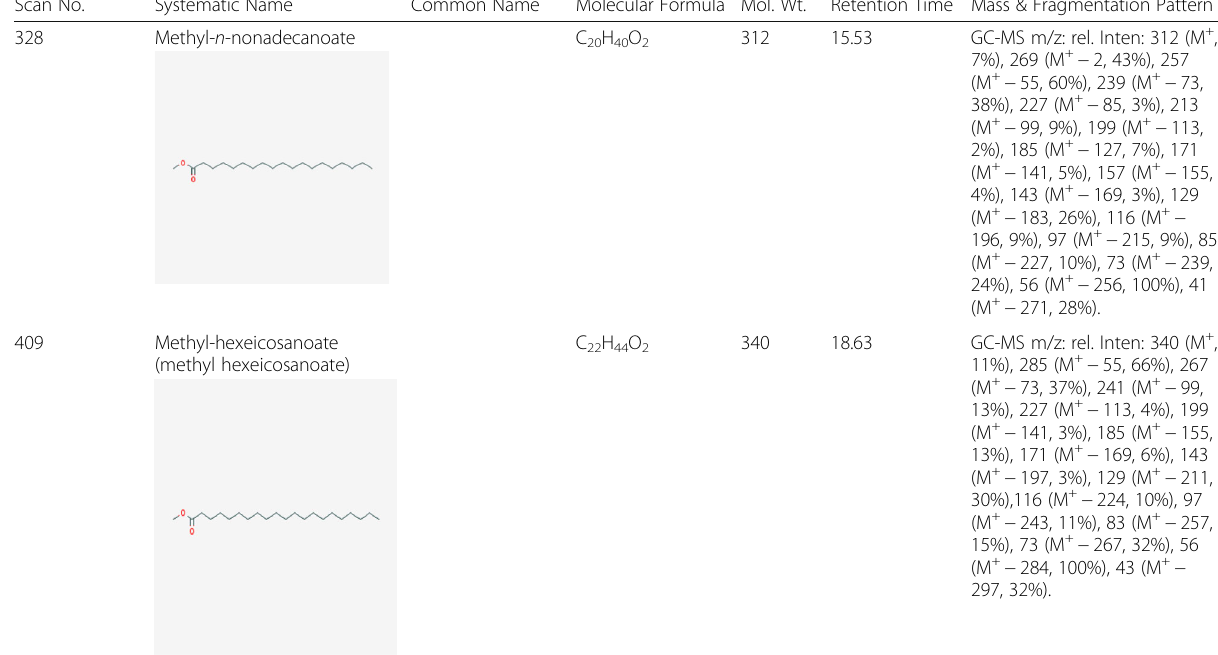
Table 4 GC-MS of Fraction F46 from Stokeyia indica Scan